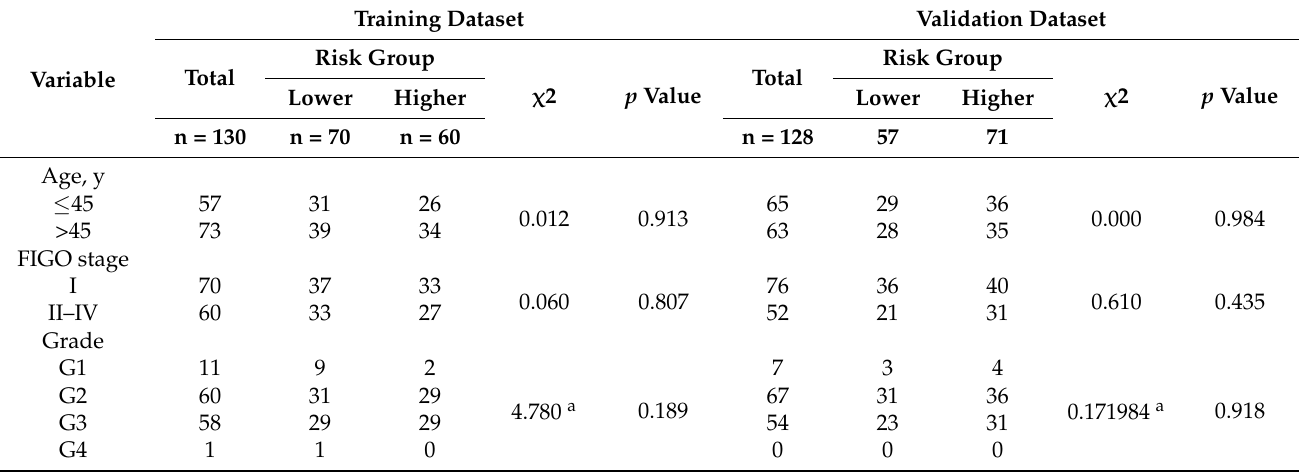
Table 1. Clinical and Pathologic Characteristics of The Patient with Cervical